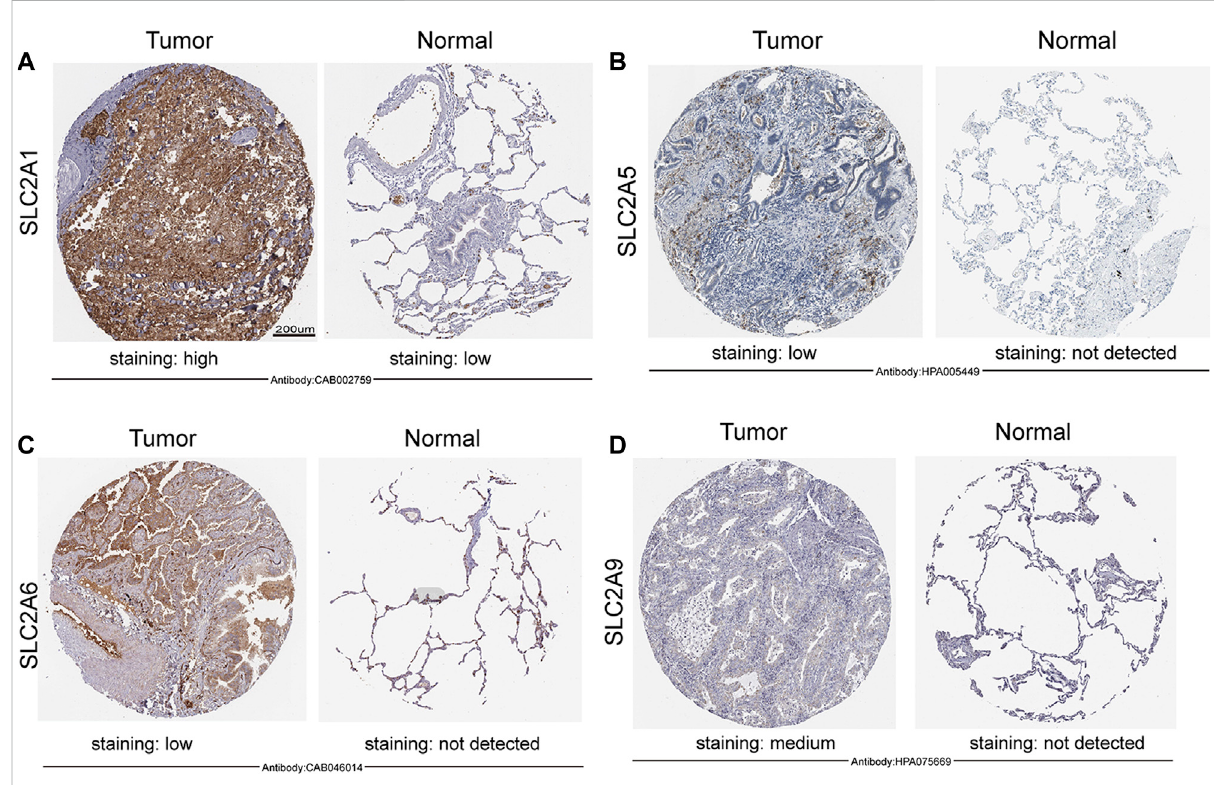
FIGURE 2 Expression of SLC2As protein in LUAD tissues and adjacent lung tissues (HPA). Scale bar, 200 µm. (A) Lung tissues displayed low GLUT 1 expression while LUAD tumors showed high protein expressions of it. (B – D) GLUT 5, GLUT 6, GLUT 9 were not expressed in normal lung tissues, while low or medium protein levels were expressed in LUAD